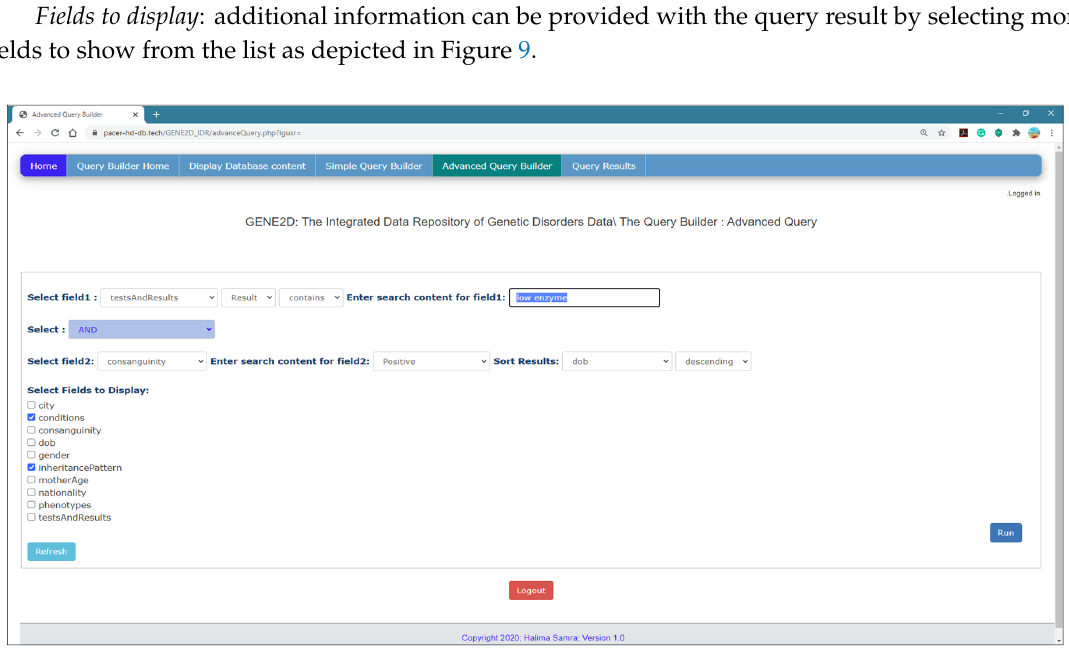
Figure 9. The Advanced Query Builder page.